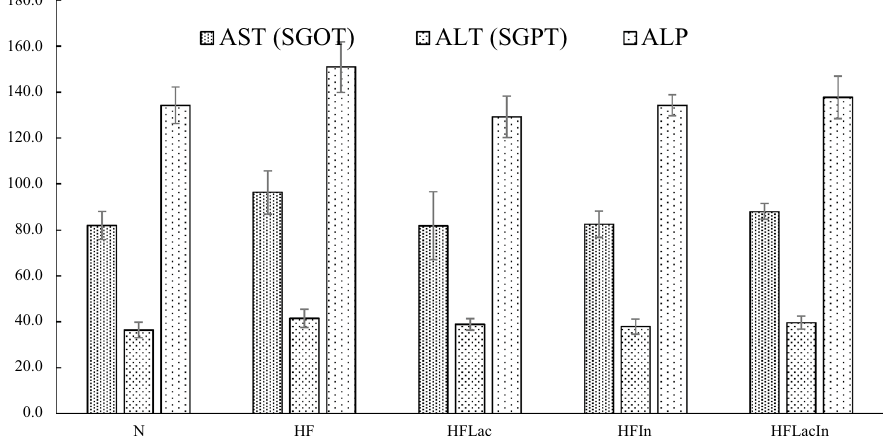
0.0 Figure 3. Serum liver enzyme activities (U/dL) of the rats in each group (n = 13). (N) Rat fed a normal diet (HF) Rats fed with a high fat diet (HFLac, HFIn, HFLacIn) Rats fed with a high fat diet and L. acidophilus , inulin, and L. acidophilus + inulin, respectively. AST aspartate transaminase, ALT alanine transaminase, ALP alkaline